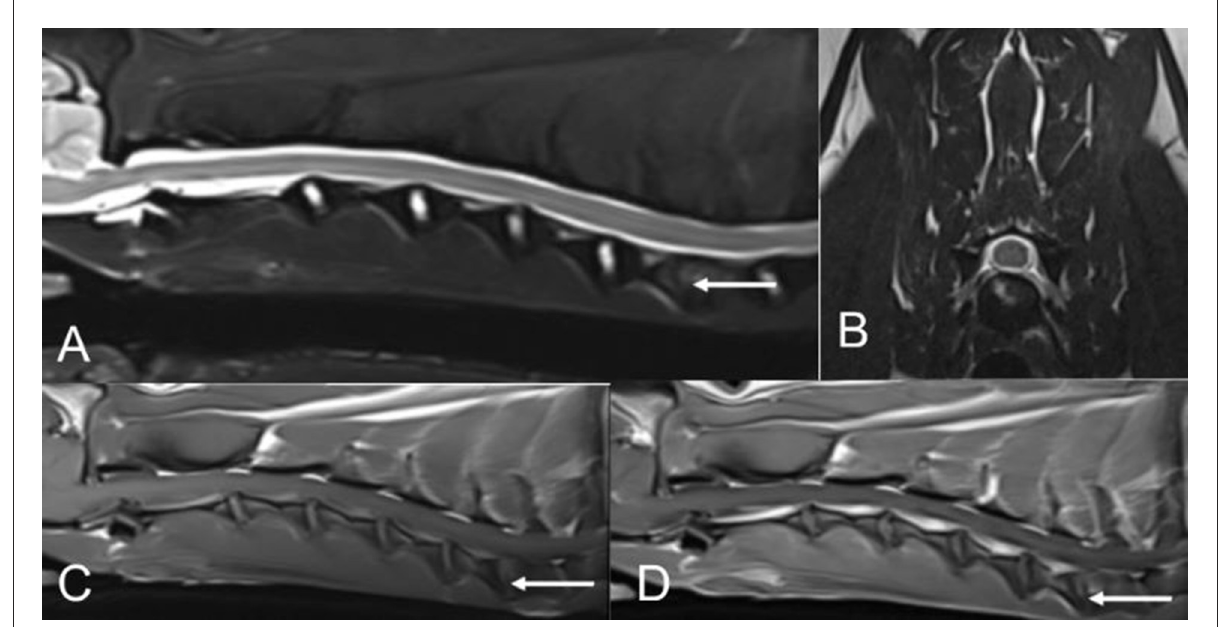
FIGURE1 MR images of the cervical spine from patient #1. (A,B) T2W sagittal and T2W transverse (at the level of the C6-C7 intervertebral disc space). (C) T1W sagittal pre-contrast. (D) T1W sagittal